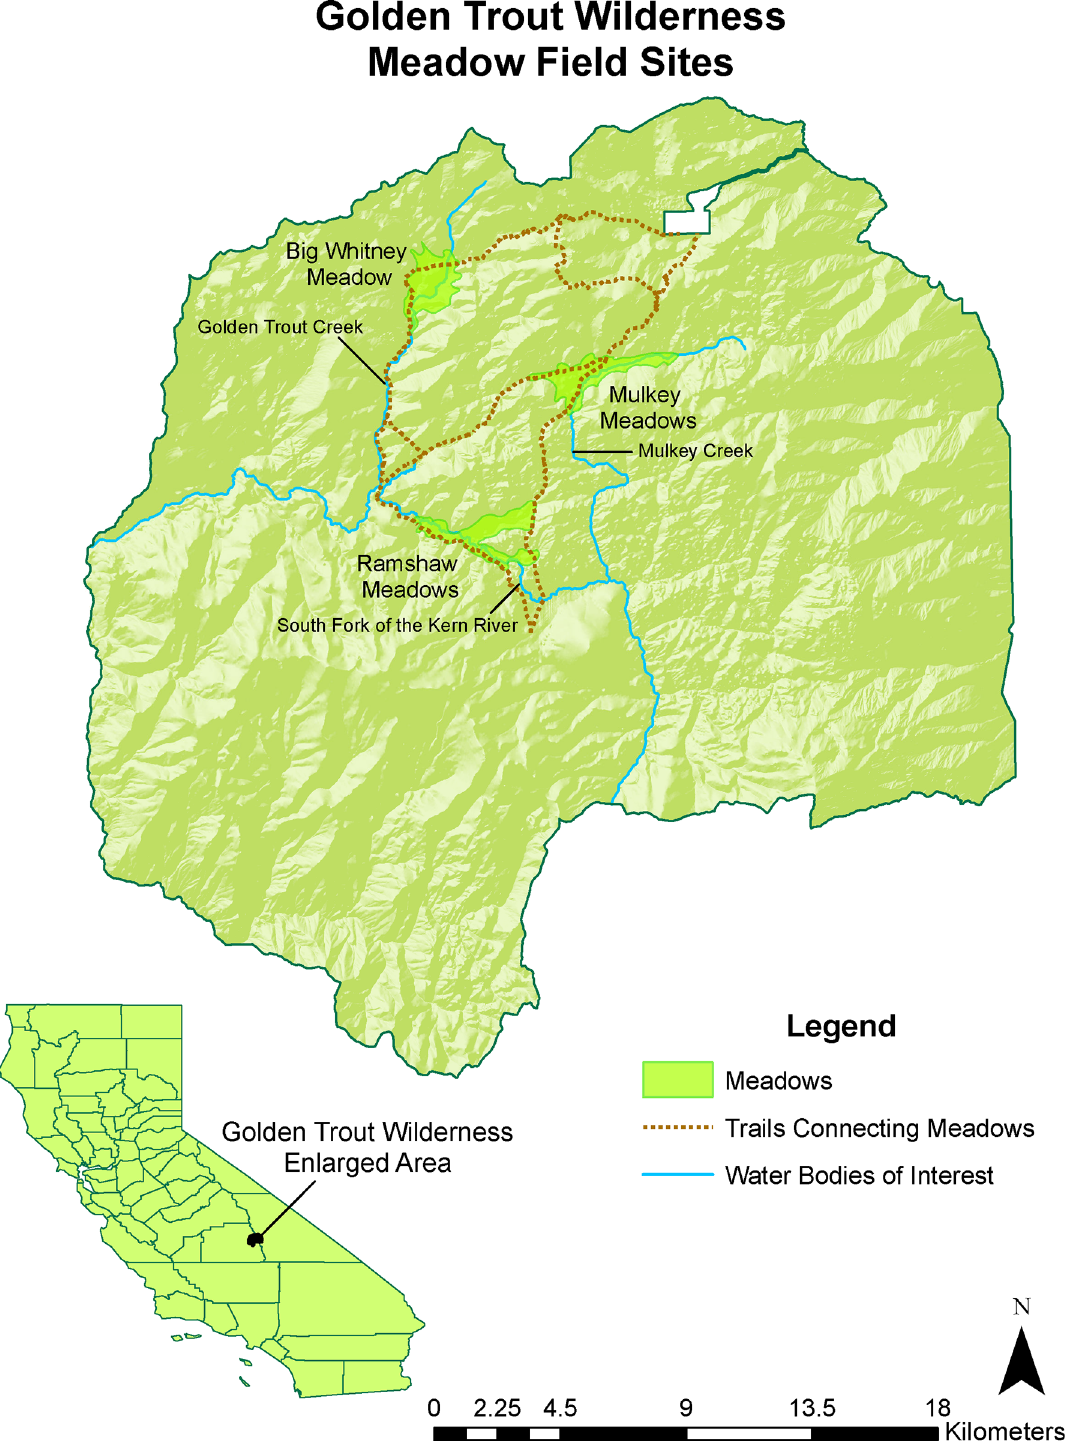
Fig 1. Study area. Data were collected in three distinct meadow systems of the Golden Trout Wilderness, California, a protected area within the Inyo National Forest in the Sierra Nevada mountains, which is the last remaining habitat of the Golden Trout ( Oncorynchus mykiss aquabonita ). Water temperature was measured between 2008 – 2013 in three rivers: (1) Mulkey Creek, within Mulkey Meadows, between 2827 – 2844 m in elevation, (2) the South Fork of the Kern River within Ramshaw Meadows, between 2629 – 2648 m, and (3) the Golden Trout Creek within Big Whitney Meadow, between 2931 – 2964